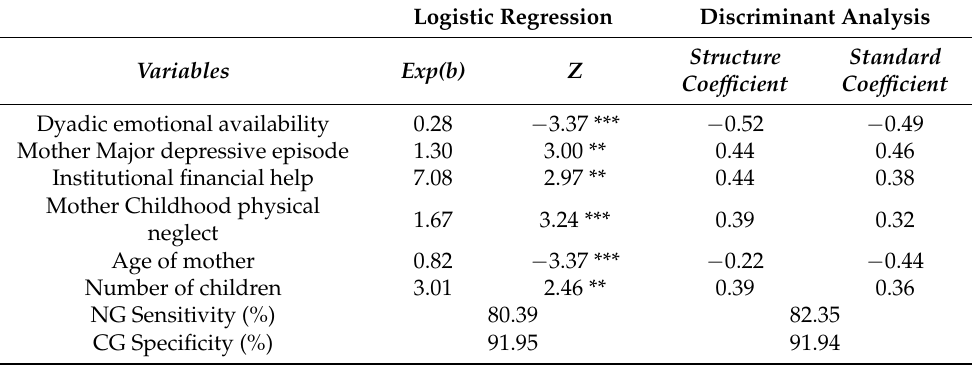
Table 4. Estimated exponential b parameters in the logistic regression and discriminant coefficients as well as diagnostic accuracy values for the distinction of the neglected group (NG) and the non- neglected control group